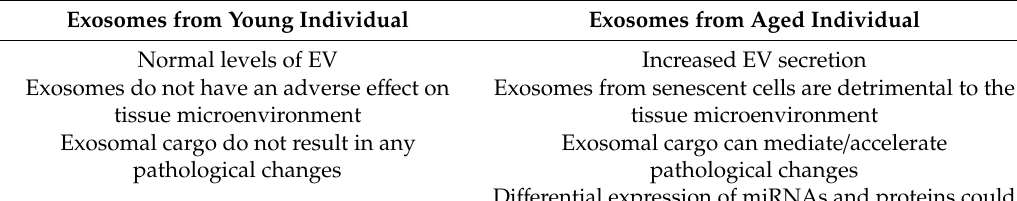
Table 1. Salient features of exosomes from young vs. aging individuals.